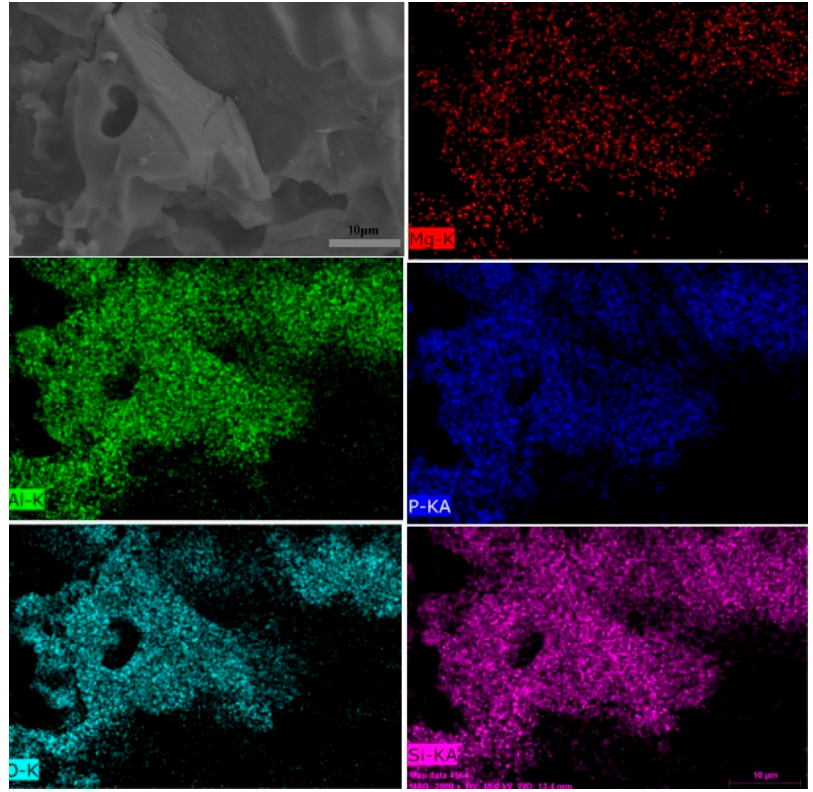
Figure 17. SEM–EDX results of the sintered specimens formed at 1000 °C.